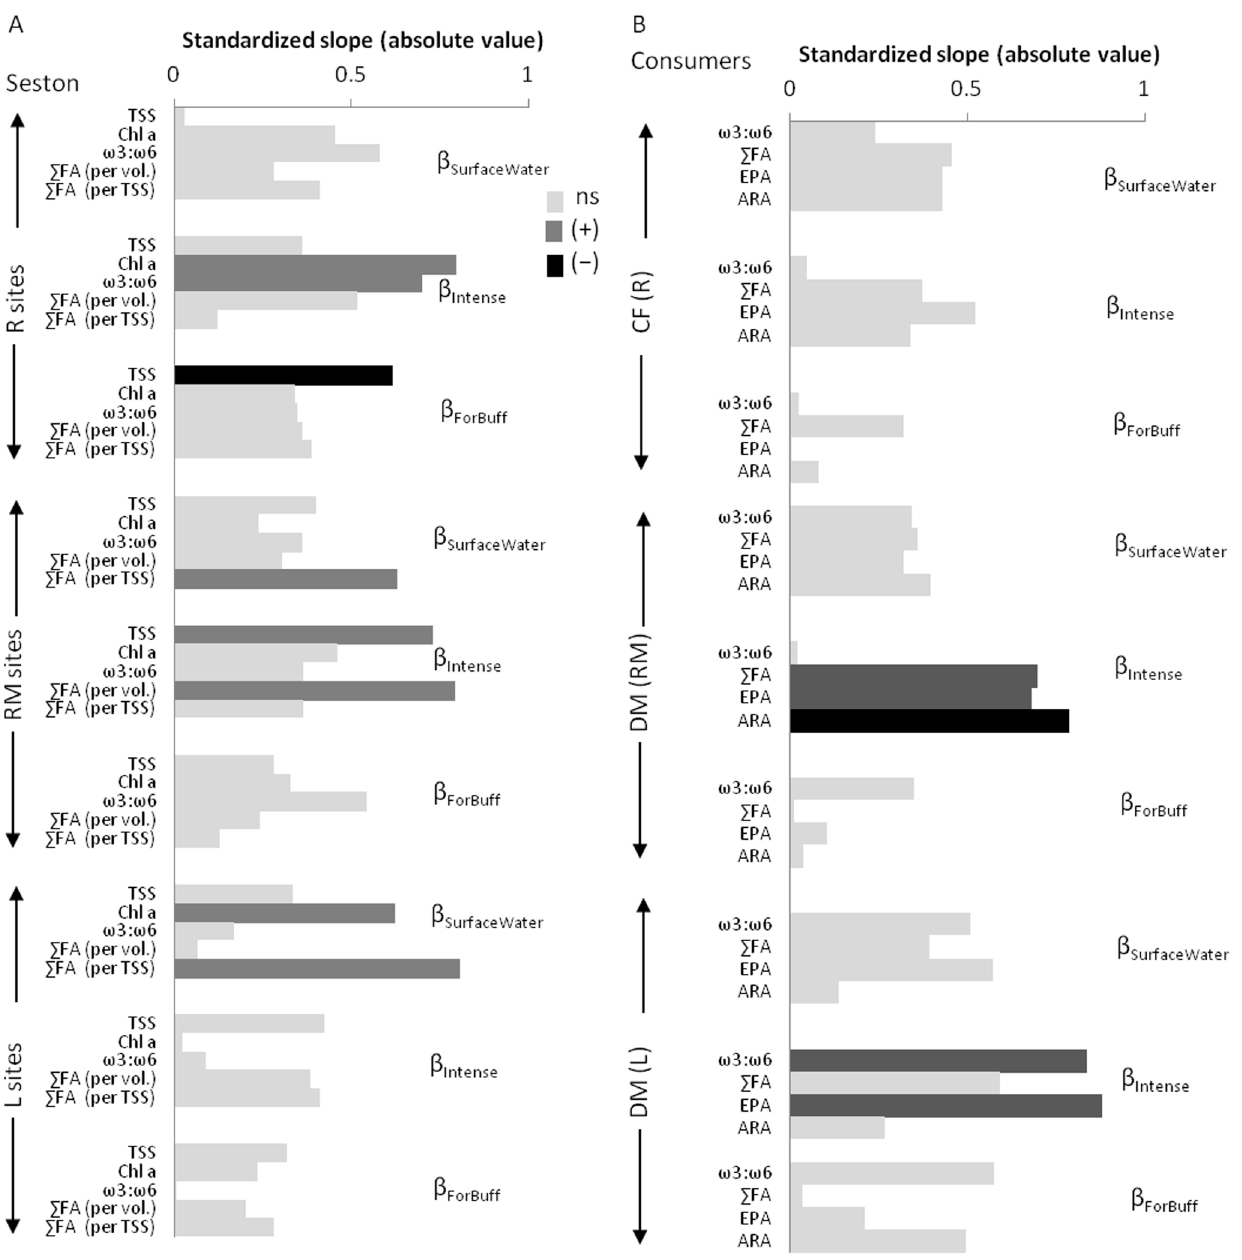
Figure 5. Standardized slopes ( b ) between land cover characteristics and fatty acid (FA) properties. A) Relationships between land cover and seston TSS, chlorophyll a and FA properties at river (R), rivermouth (RM) and nearshore lake Michigan sites (L). B) Relationships between land cover and consumer FA properties at R, RM and L sites. Other measured FA metrics not presented here vary in the same manner as total fatty acids ( g FA; Table S3). Slopes where 95% credible intervals overlapped zero are colored light grey and indicate non-significant (ns) relationships. Statistically significant positive ( + ) relationships are shaded dark grey, while statistically significant negative ( 2 ) relationships are shaded black.